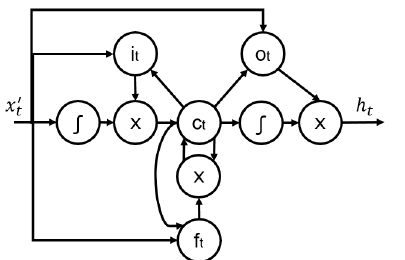
Figure 3. Neuron structure of an LSTM, reproduced from